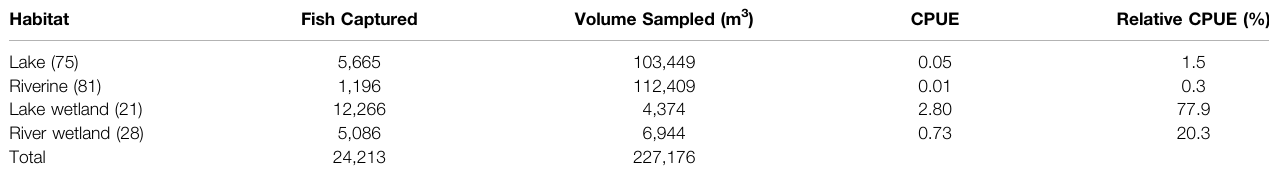
TABLE 3 | Fish catch per unit effort by habitat type (sample number) within Mildred Island, Sacramento – San Joaquin Delta, 1 July to 31 August 2018. Habitat